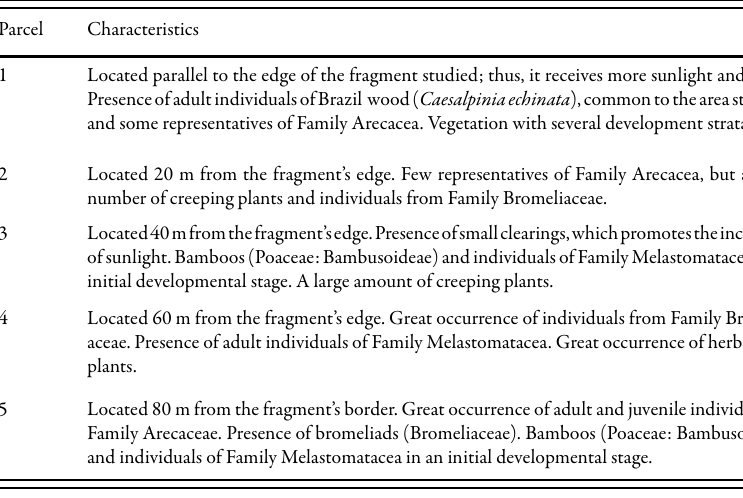
Table 1. Characteristics of parcels studies in an Atlantic Forest fragment at the Tapacurá Ecological Station, Pernambuco,